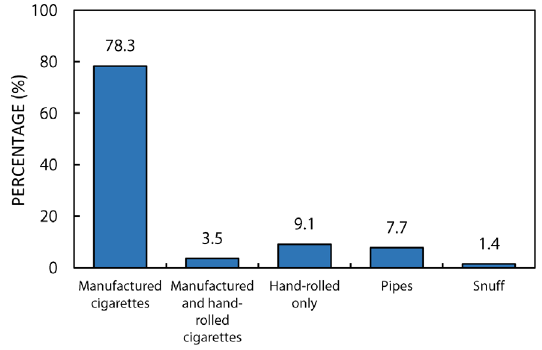
Figure 3: Types of tobacco products used by participants.